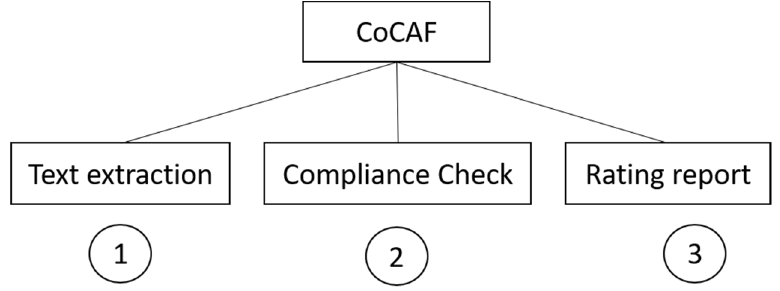
Figure 2 . The continuous compliance awareness framework (CoCAF) .